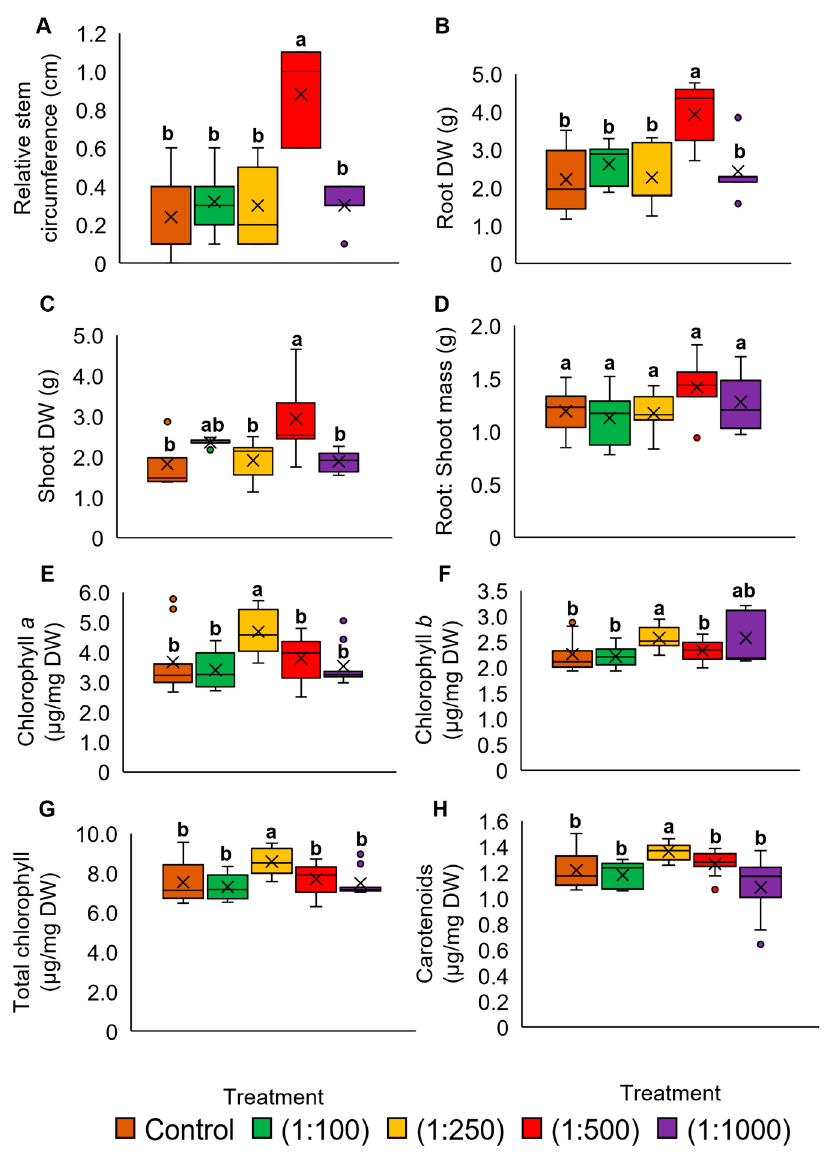
Figure 1. The plant morphological and pigment analyses of the Pandanus amaryllifolius treated with different dilution factors of oil palm wood vinegar (OPWV). ( A ) Relative stem circumference. ( B ) Root dry weight (DW). ( C ) Shoot DW. ( D ) The root-to-shoot ratio. ( E ) Chlorophyll a ( µ g mg − 1 DW). ( F ) Chlorophyll b ( µ g mg − 1 DW). ( G ) Total chlorophyll ( µ g mg − 1 DW). ( H ) Carotenoids ( µ g mg − 1 DW). The letter labelled on the mean value indicates a significant level between treatments based on the one-way ANOVA, followed by the post hoc Tukey test when its p -value < 0.05. The letter ‘a’ above the bars indicates the highest value, followed by ‘ab’ and ‘b’. The (×) labelled in the box plot indicates the mean value of the treatment, while the (•) refers to the outlier value of the replicates.